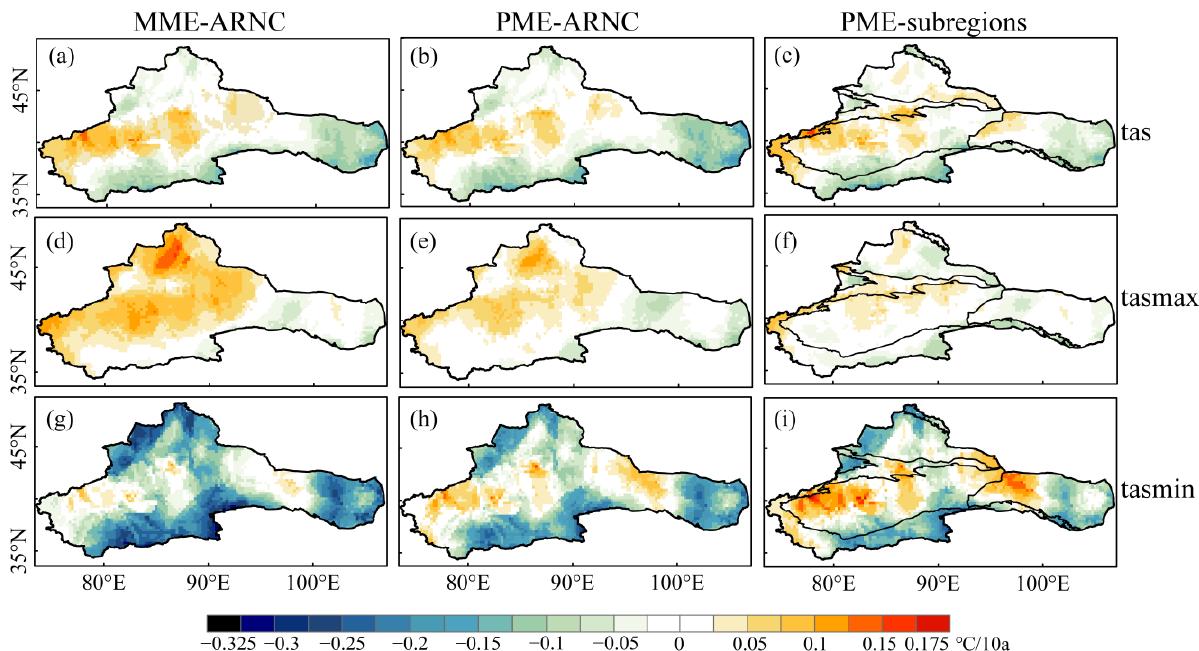
Figure 6. Bias field (simulation field minus observation field) of temperature trend under MME ( a , d , g ), PME ( b , e , h ) and PME of subregions ( c , f , i ) during 1961 – 2014. Upper row, tas; middle row, tasmax; bottom row, tasmin.